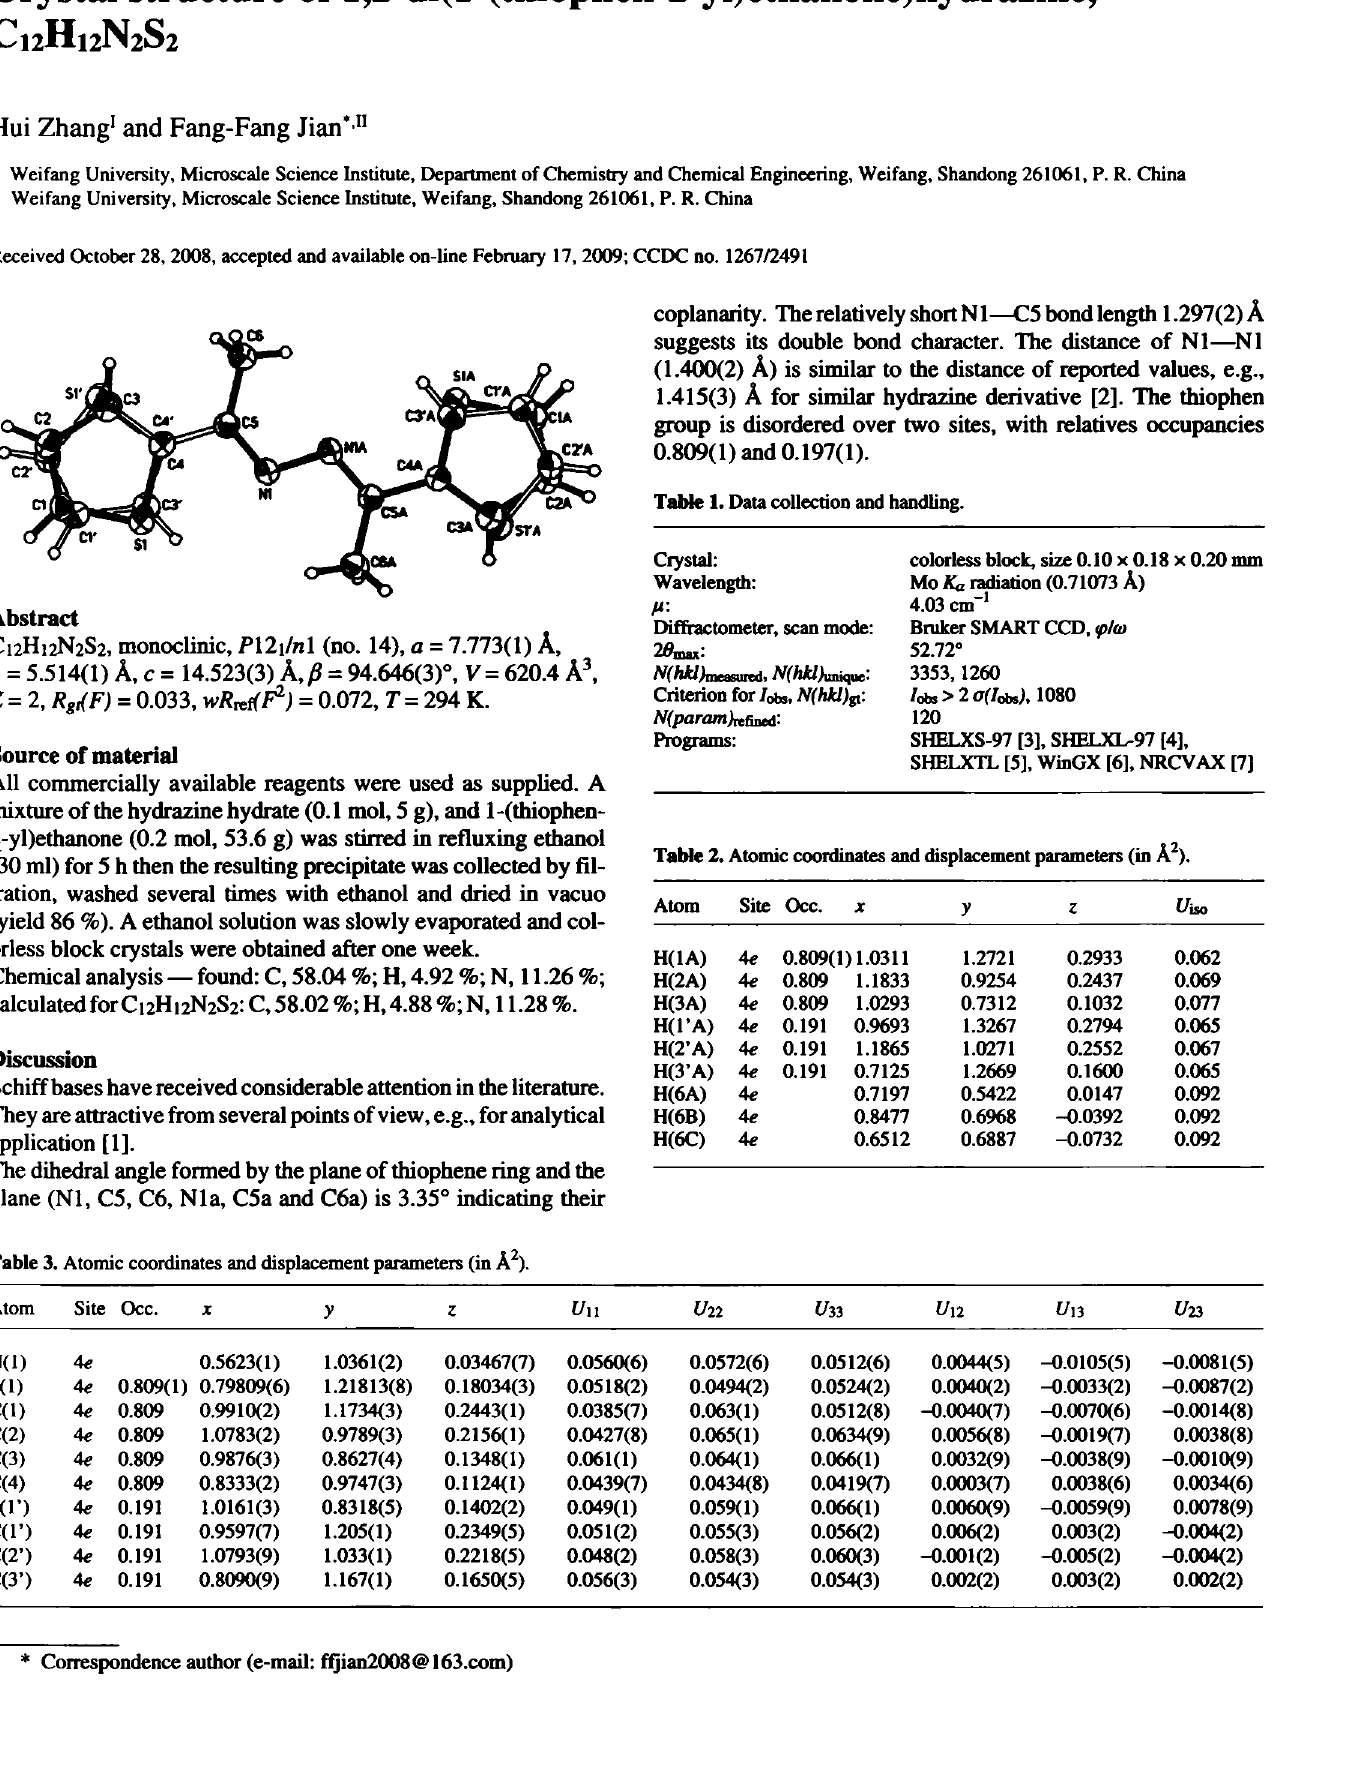
Table 3. Atomic coordinates and displacement parameters (in A 2 ). Atom Site